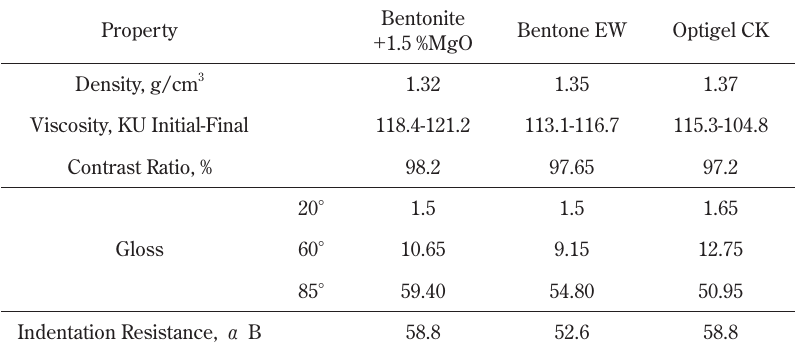
Table 8 Key physical properties of paints using different thickeners